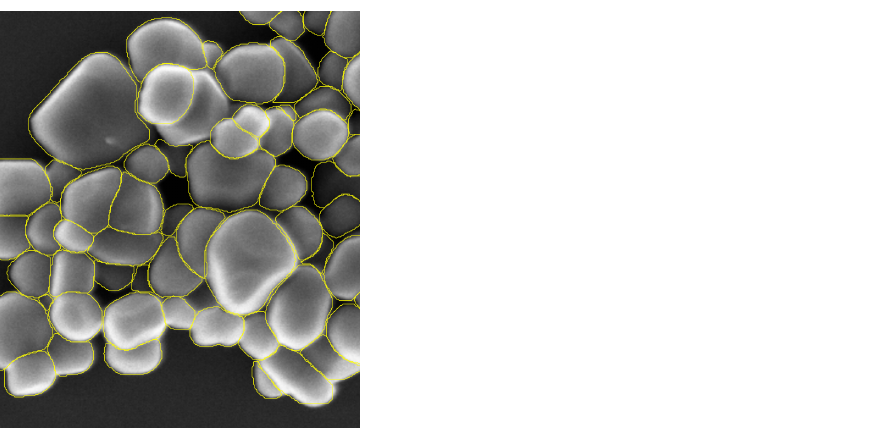
Figure 11. Predicted segmentation over SEM image of agglomerated TiO 2 particles, zoom × 8.